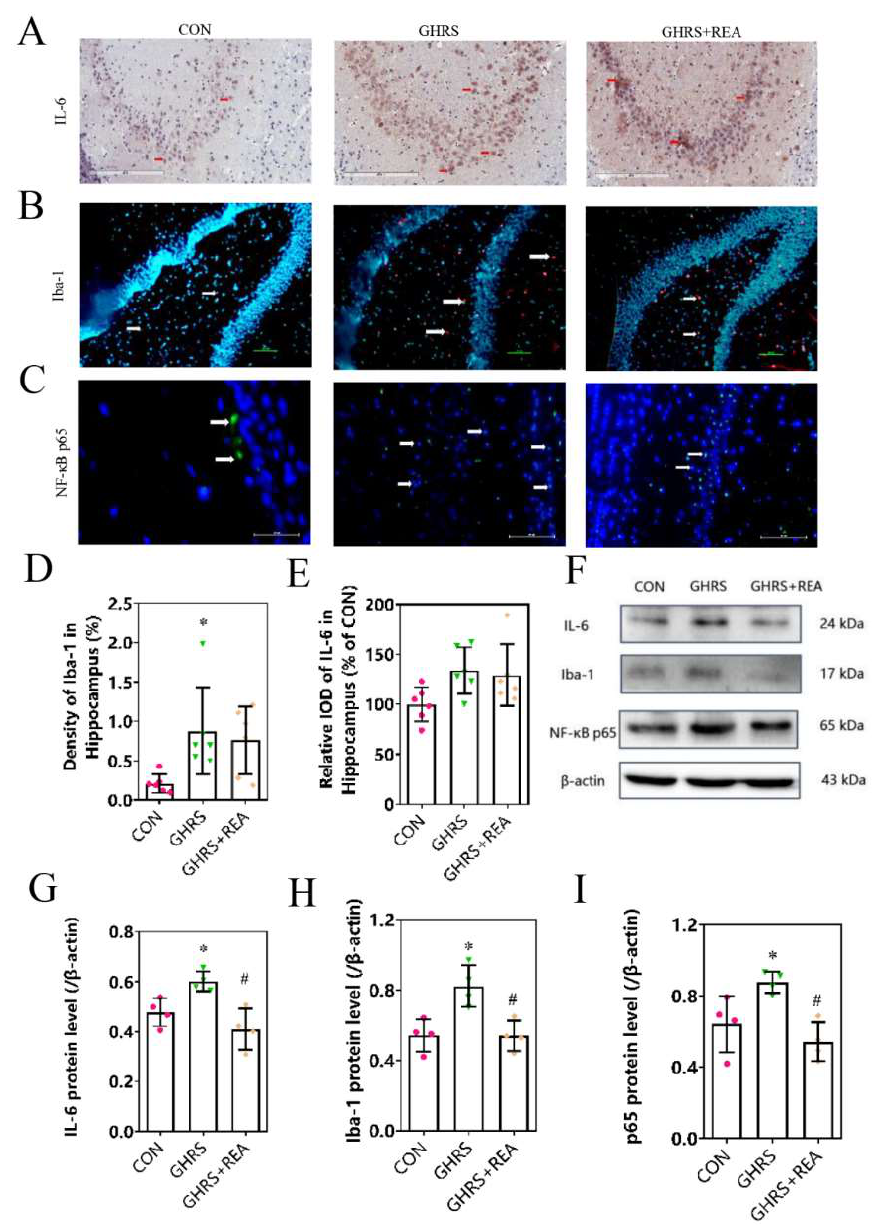
Figure 3. The expression of inflammatory factors in the brain of rats. ( A ) Representative immunohistochemistry photographs showing IL-6 localization in the hippocampus of rats. ( B ) Representative immunofluorescence photographs showing Iba-1 localization in the hippocampus. ( C ) The nuclear translocation of NF- κ B p65 in the hippocampus. ( D , E ) The protein levels of Iba-1 and IL-6 in the hippocampus, n = 6. ( F ) The protein bands of IL-6, Iba-1, and NF- κ B p65 in the cortex. ( G – I ) The protein levels of IL-6, Iba-1, and NF- κ B p65 in the cortex, n = 4. Each column presents the mean ± SD. * p < 0.05 compared with CON group, # p < 0.05 compared with GHRS group.